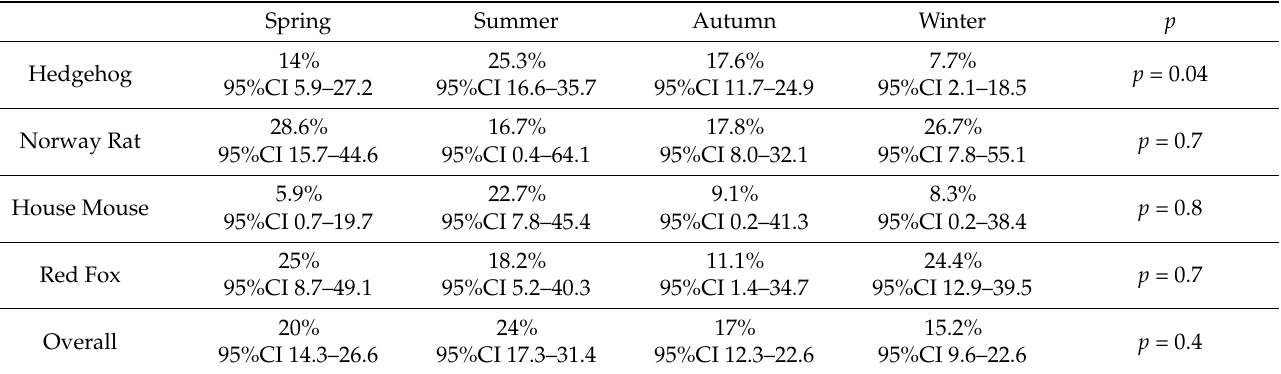
Figure 2. Sequence-Type (ST) geographical distribution. The size of each pie chart represents the total number of samples, the colors represent the different Sequence Type found for each Italian province analyzed. Table 4. Prevalence of Leptospira spp. infection and confidence interval (95%CI) for each season are reported for the overall population and for the hedgehog, Norway rat, house mouse and red fox species. p values from the GLMM analysis are